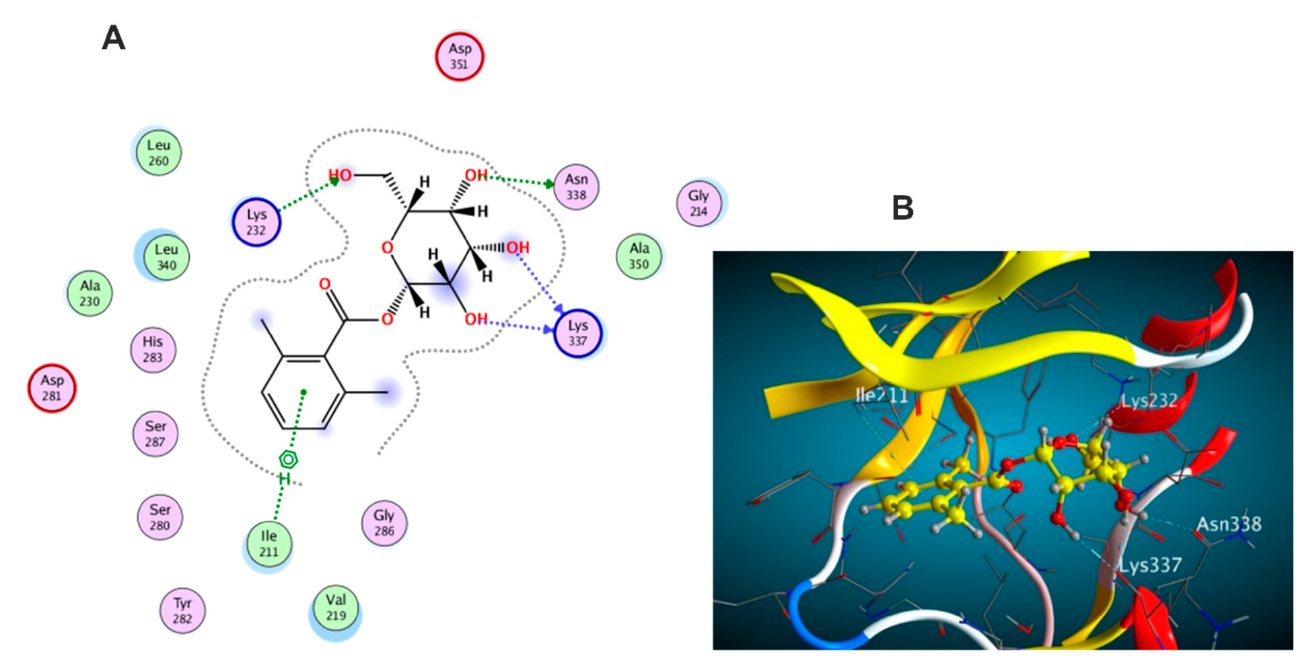
Figure 9. Docking results of compound 14 in the active pocket site of (TGF- β ) (6B8Y): ( A ) 2D inter- actions of ligand; ( B ) 2D interactions of compound 14 ; ( C ) 3D Docking pose of compound 14 .